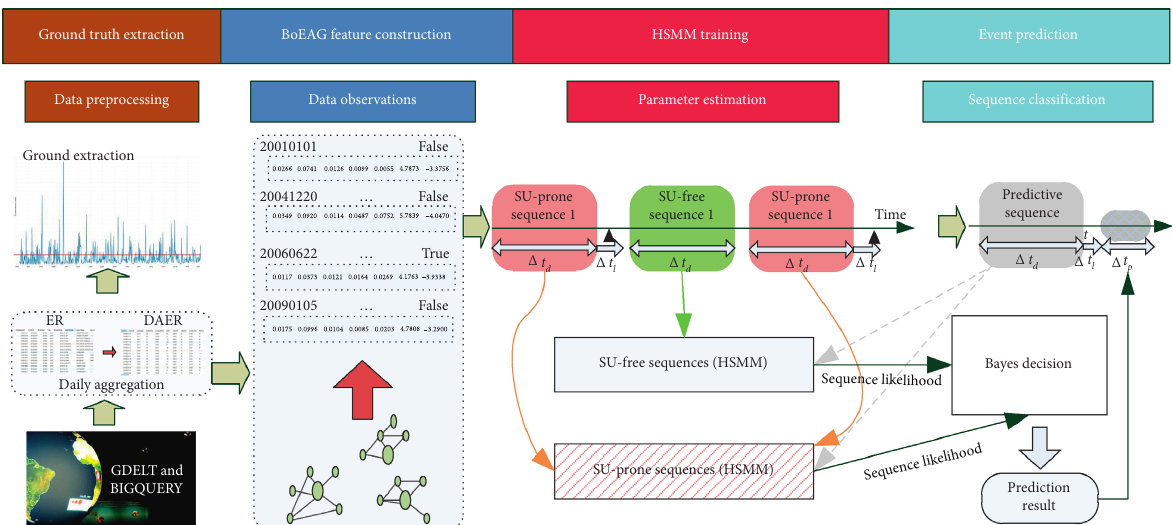
Figure 2: Prediction mechanism of upcoming social unrest events. t : present time; Δ t Δ t d : data window